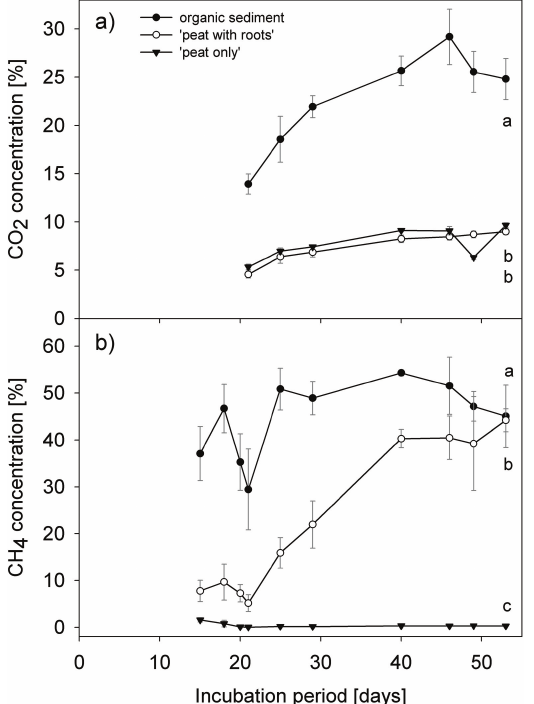
Fig. 2. Organic substrate incubation: CO 2 (a) and CH 4 (b) con- centrations in the silicone probes over a 53-day period at constant temperature of 15 ◦ C (mean ± SD, n = 3). Three organic substrates (organic sediment, “peat with roots” and “peat only”) taken from the uppermost peat layer are compared (different letters indicate signif- icant differences, p < 0 . 001, 1% = 10000ppm).